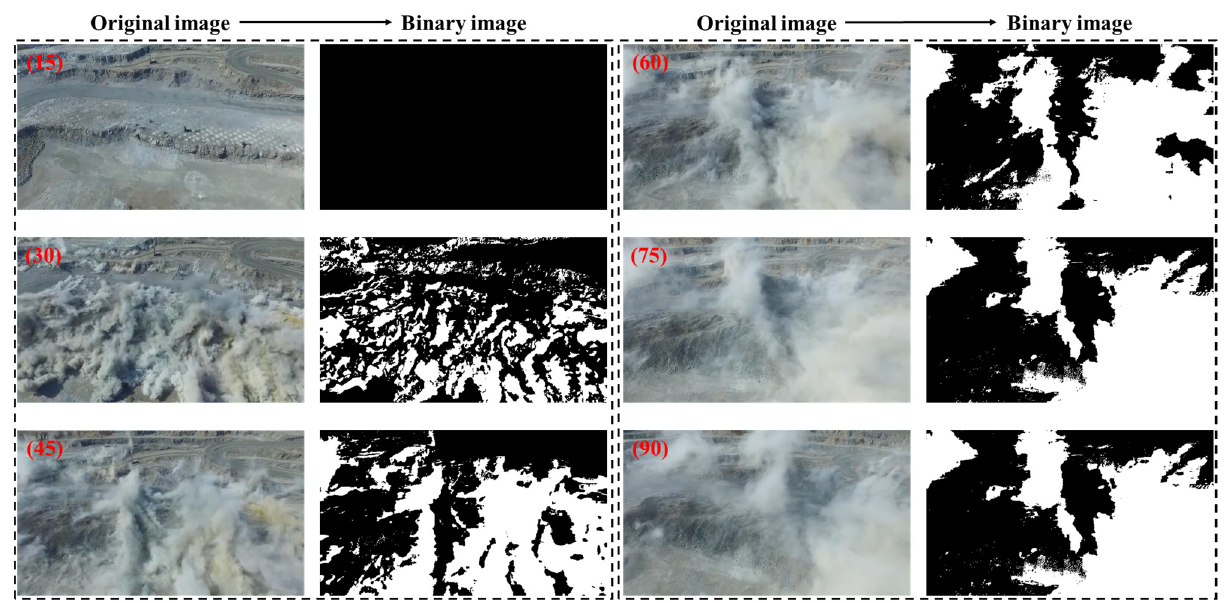
Figure 6. Partial visualization results of the image-processing operations, including original images and binary images, corresponding to the 15th, 30th, 45th, 60th, 75th and 90th images.